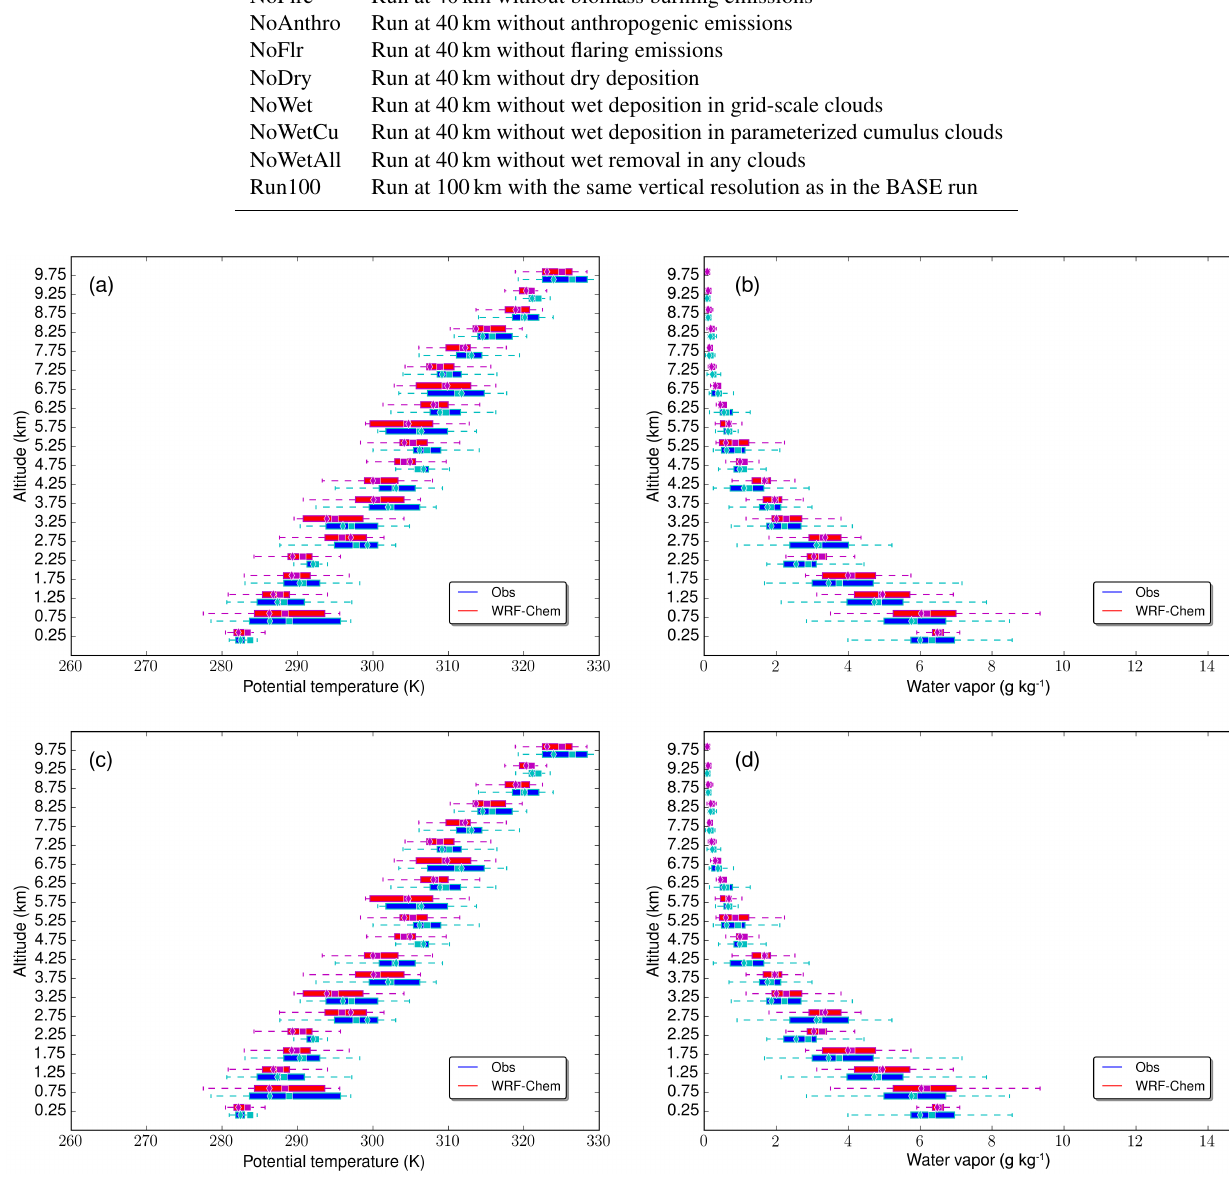
Figure 2. Vertical profiles of observed (blue) and modeled (red) (a) potential temperature (K), (b) water vapor mixing ratio (gkg − 1 ), (c) wind speed (ms − 1 ) and (d) wind direction ( ◦ ) interpolated along all the 14 Falcon flight tracks. Boxes represent the interquartile range, diamonds are the median values, squares show the means and whiskers show the minimum and maximum of the